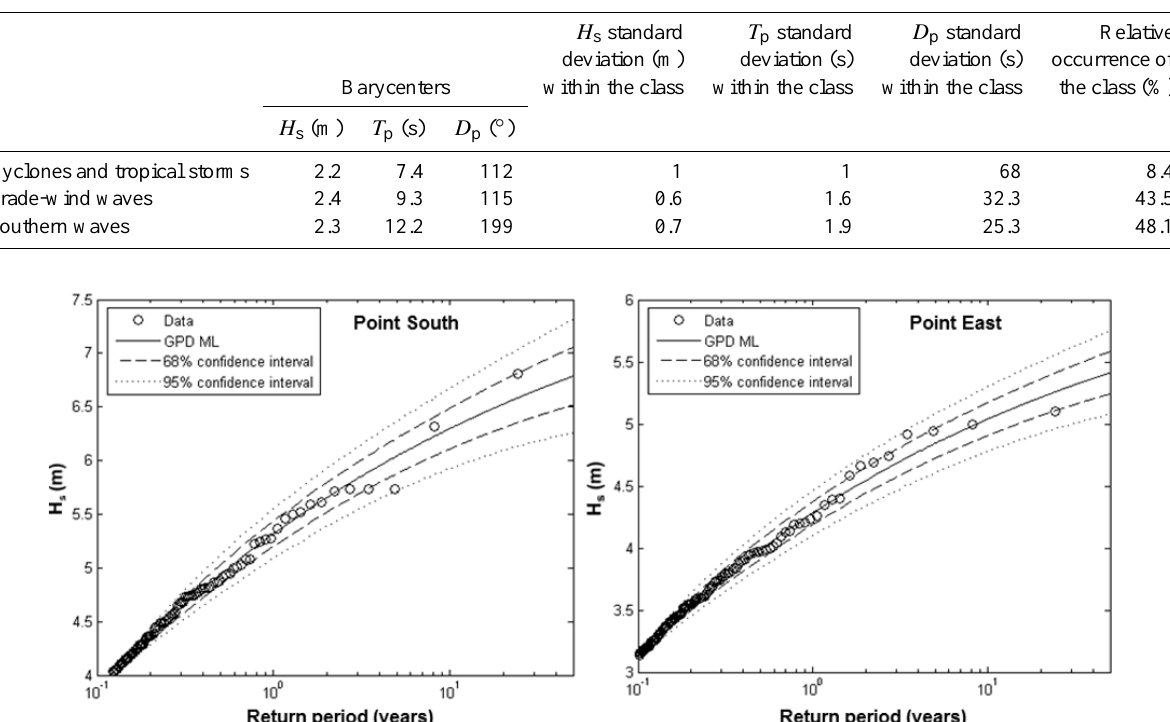
Fig. 4. Return values of H s for southern waves at “Point South” (left) and trade-wind waves at “Point East” (right) obtained with the POT method and GPD laws. Results are presented up to a return period of 50yr.